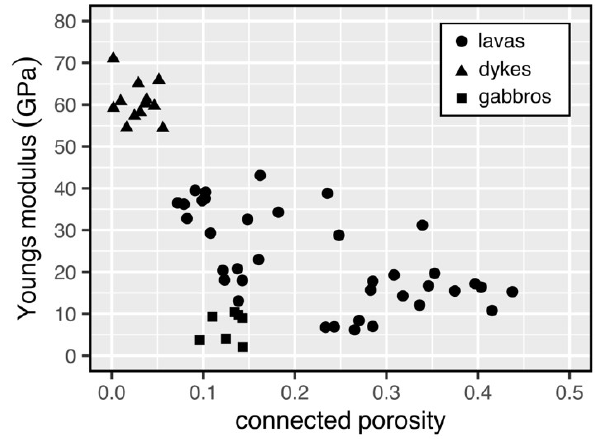
Figure 9: Young’s modulus as a function of total poros- ity for the basaltic rocks from La Réunion collected for this study (data available in Table